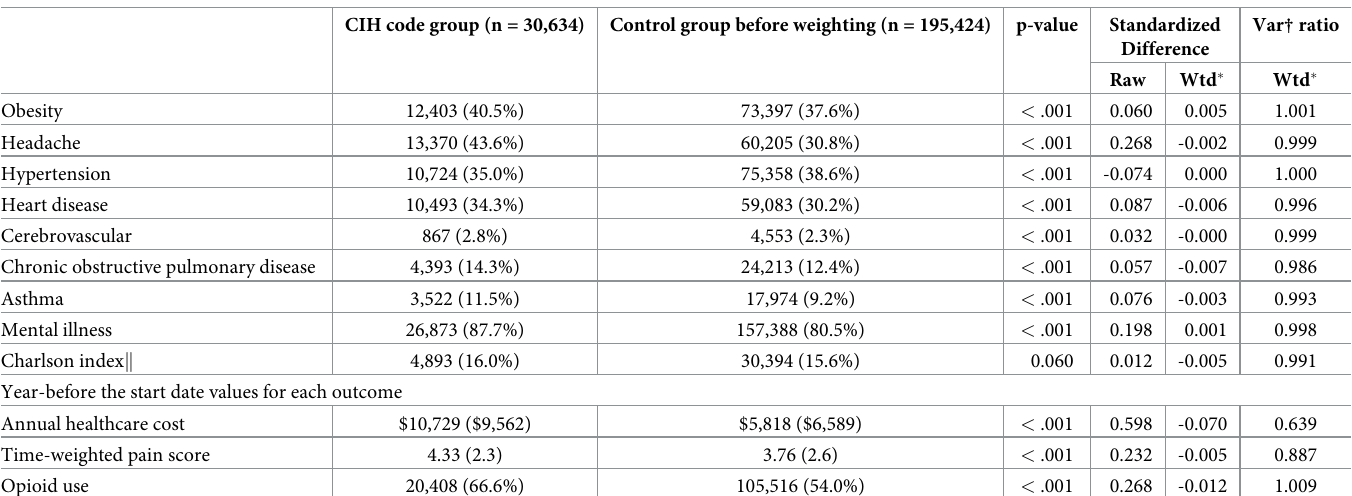
Table 2 reports the results of the HLM models. The negative significant coefficients for time indicated that healthcare costs, pain and opioid use all generally decrease over the two- year period for the control group. The significant CIH user coefficients indicated that the CIH group had significantly higher healthcare costs and pain and lower opioid use to start. The positive and significant CIH x time interaction coefficients indicated that pre-CIH start trajectories are different between groups, and the size of these coefficients is such that the CIH group experienced less of a reduction in healthcare costs and a net increase in pain and opioid use in the year before CIH start. Therefore, despite the propensity score weighting the two groups have different levels of patterns of healthcare costs, pain or opioid use in the year before CIH start. Among CIH users there was a significant downward shift in the trajectories for healthcare costs and pain and significant upward shift in opioid use at CIH start (main effect of CIH start) and minor changes in slope thereafter (interaction of CIH start and time). Average monthly healthcare costs by general cost category for the CIH group in the years before and after the start date are shown in S1 Fig. The significant random effects for facility indicated that outcomes are clustered by facility. Initial model runs also indicated a small ran- dom effect on facility slope. However, this term was excluded from later models because it added little to explanatory power and significantly hampered model convergence. As shown at the bottom of the table, and according to the estimated coefficients, CIH use was associated with a significant decrease in healthcare costs and pain, and a less than a percentage point increase in opioid use compared to control. Table 3 gives the HLM results for four CIH subgroups included in our sensitivity analyses. The models for acupuncture, chiropractic care and massage all show a reduction in healthcare costs and pain and a small increase in opioid use. The subgroup with 8+ visits had a similar reduction in pain and increase in opioid use, but with an increase in healthcare